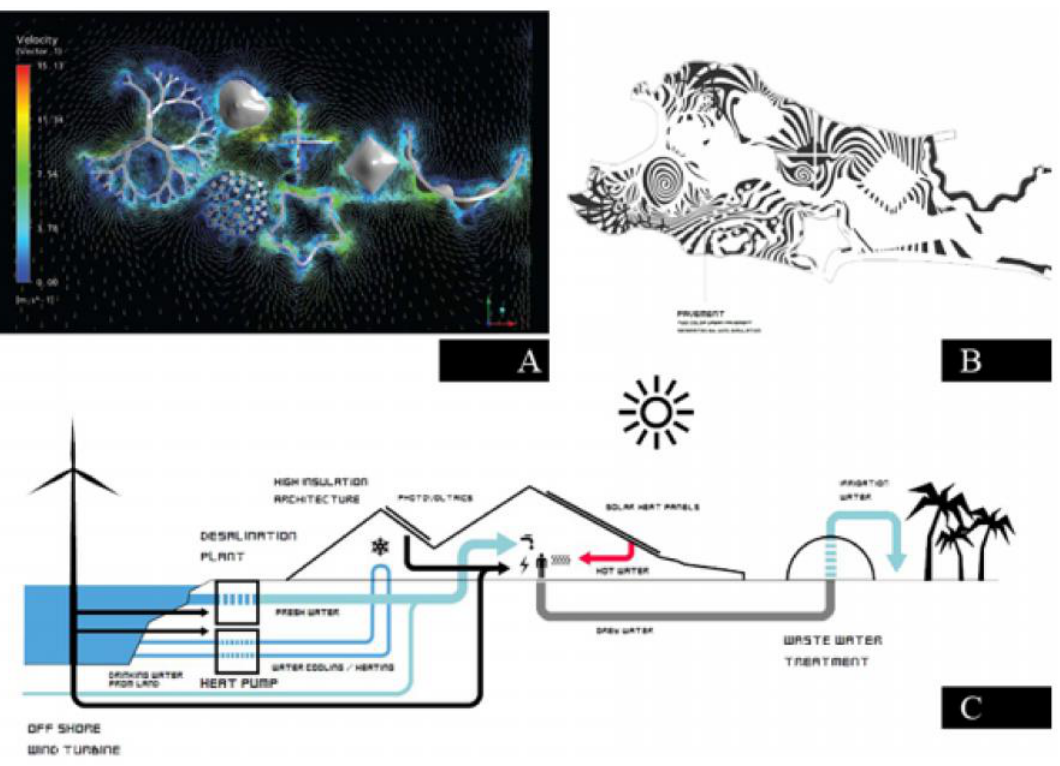
Fig. 10: A: simulation of wind flow for the Zira island –B: Pattern created in the island due to microclimate resulting from the presence of 7 artificial mountains -C: functional process considered in the new design of Zira Island (BIG,